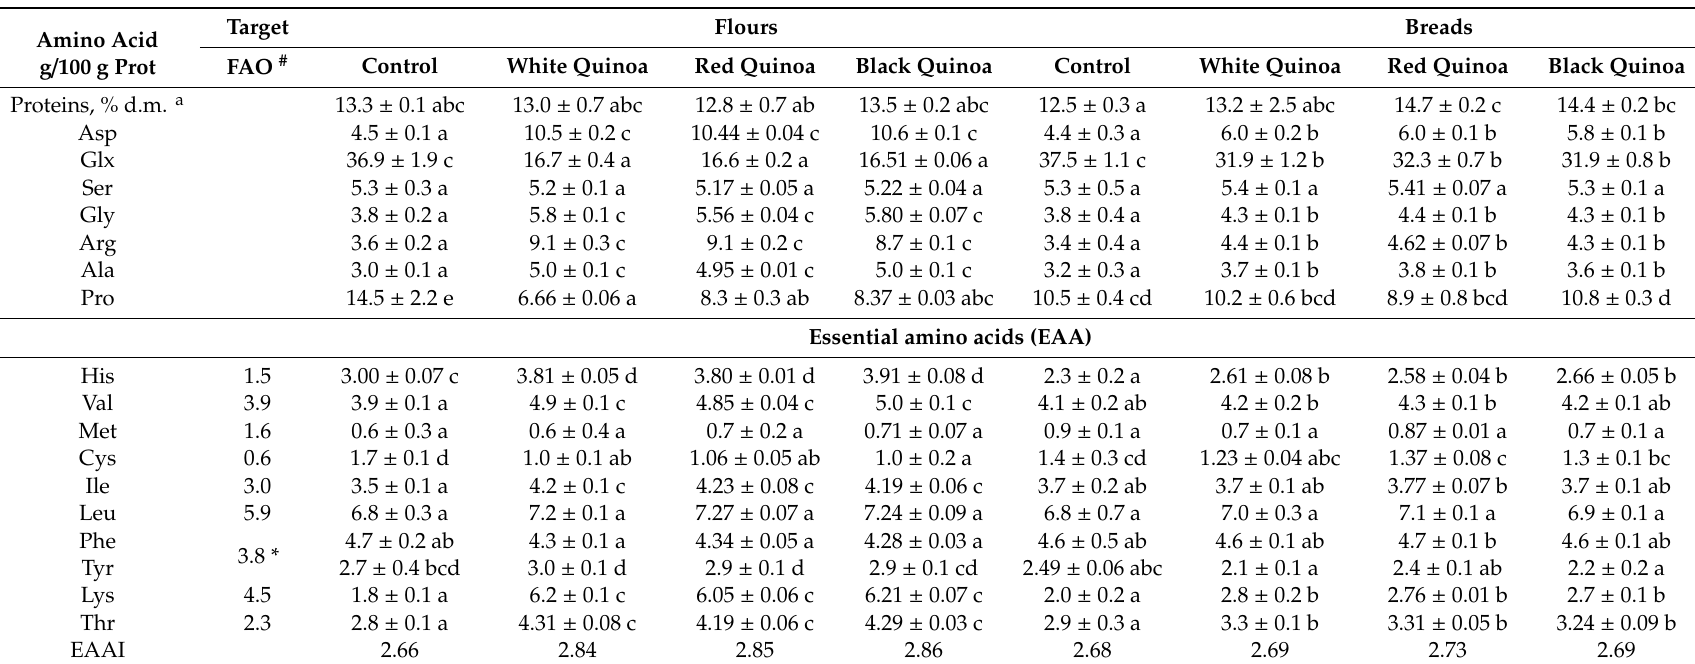
Table 1. Amino acid composition of raw materials and breads.